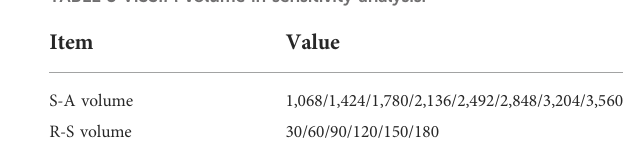
TABLE 5 VISSIM volume in sensitivity